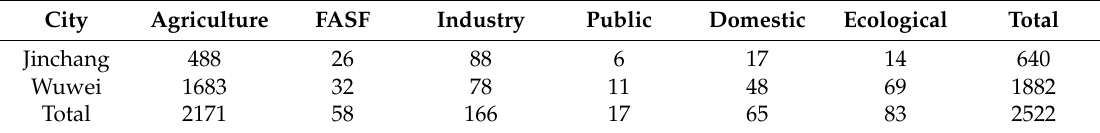
Table 2. Actual water consumption in the Shiyang River Basin in 2010 (million m 3